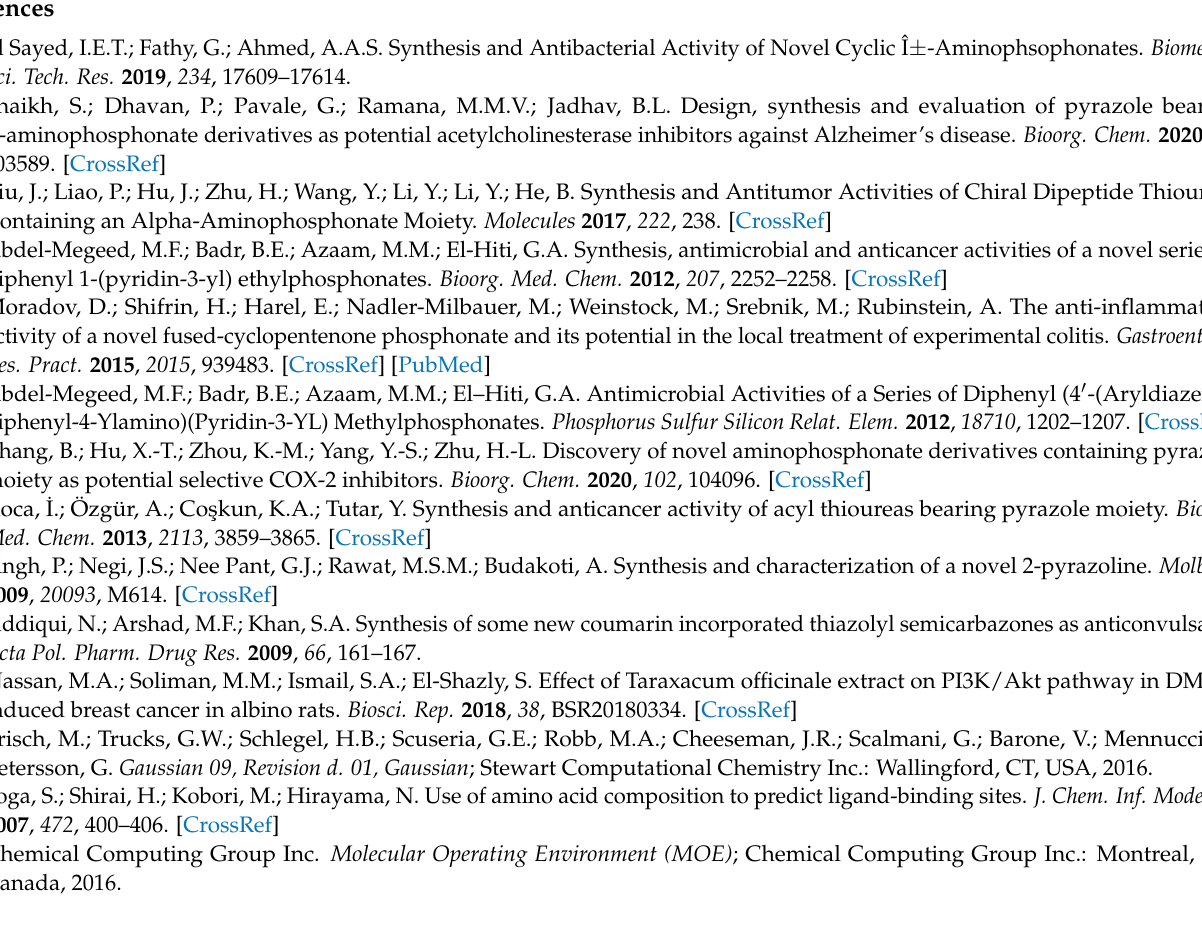
Figure S5. 1 H NMR spectra (500 MHz, DMSO-d 6 ) of